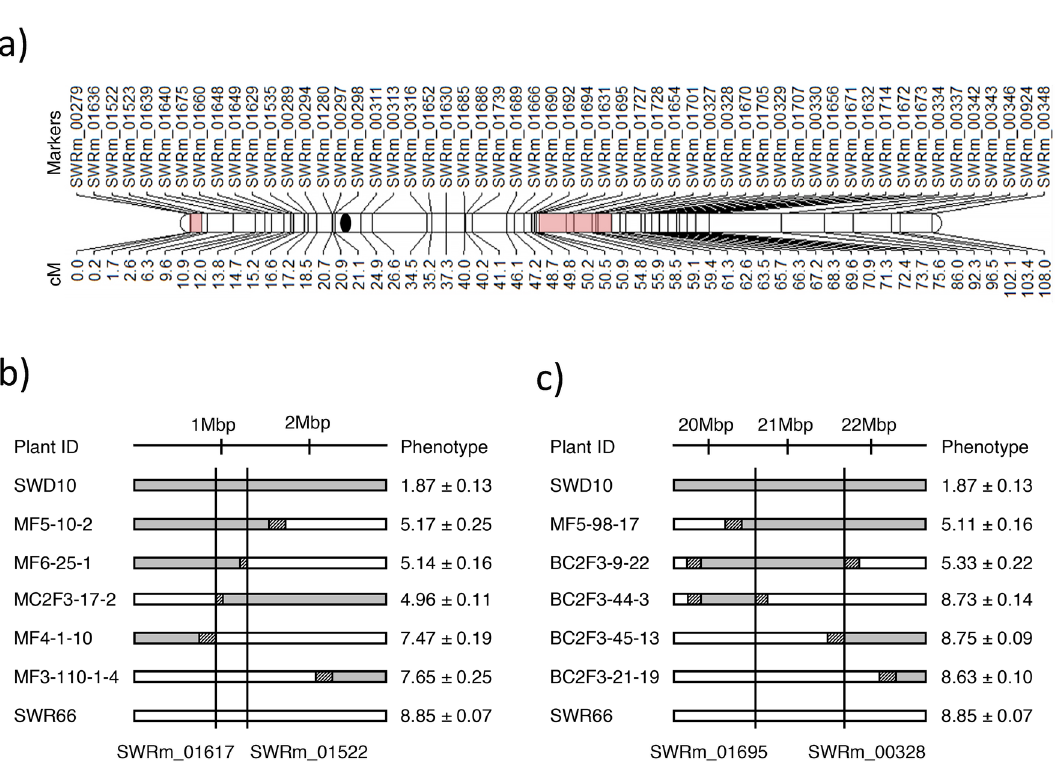
Figure 2. Delimiting BPH41 and BPH42. ( a ) Overview of polymorphic markers and their respective genetic distance on chromosome 4. The delimited QTLs for BPH41 and BPH42 are indicated with red boxes. ( b , c